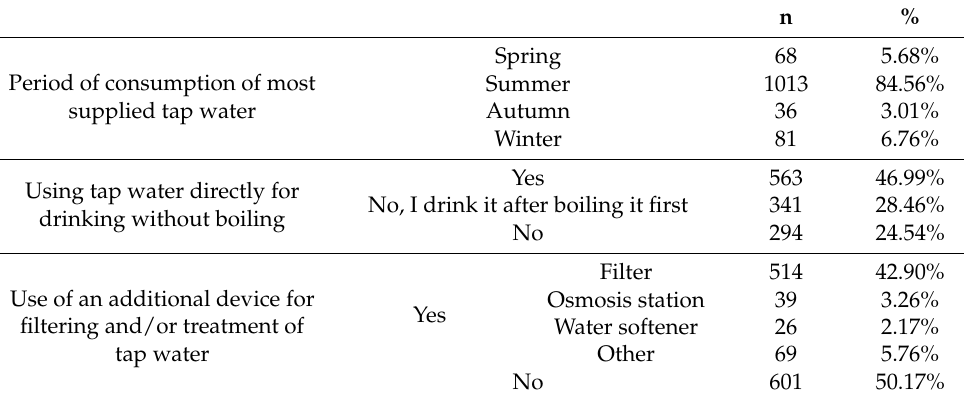
Table 2. Respondents by method of use of supplied tap